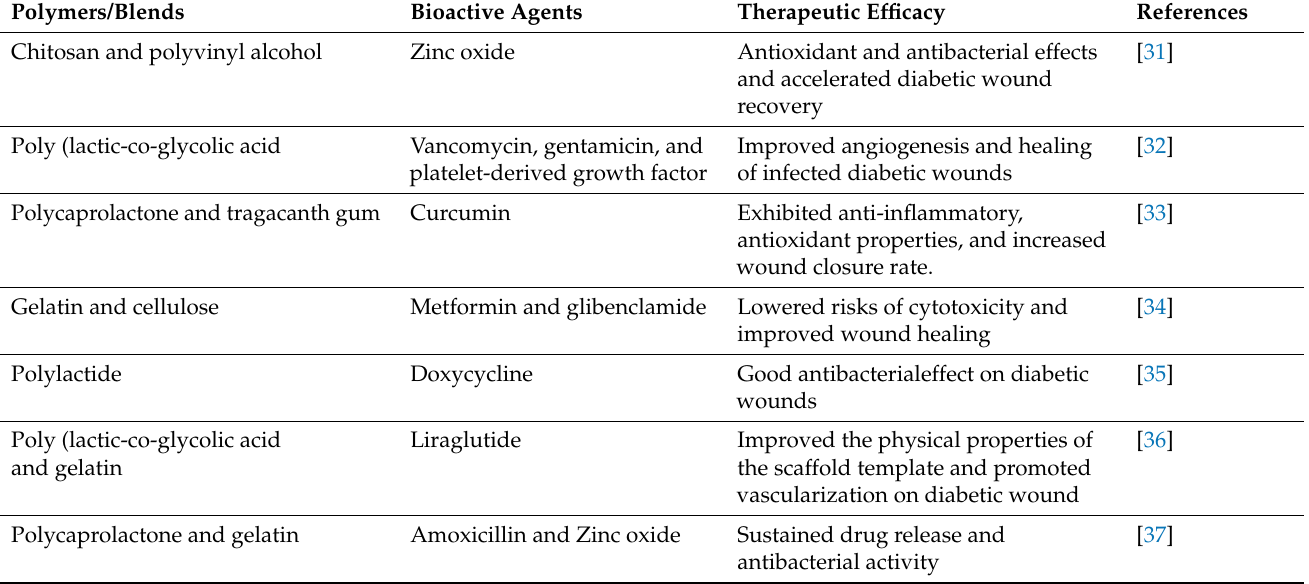
Table 1. Examples of polymer-based nanofibrous scaffold templates and their respective therapeutic